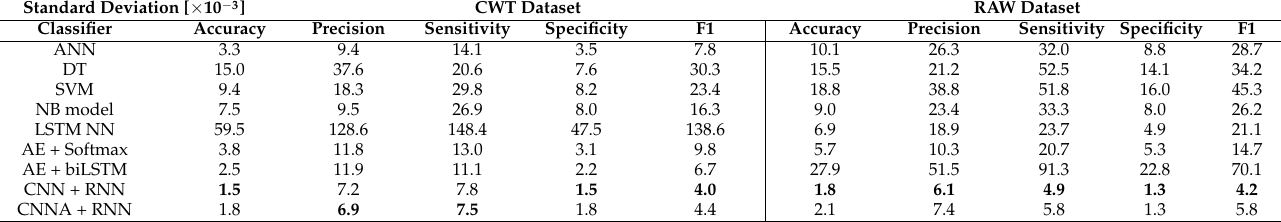
Table 5. Standard deviation of cross-validated results.